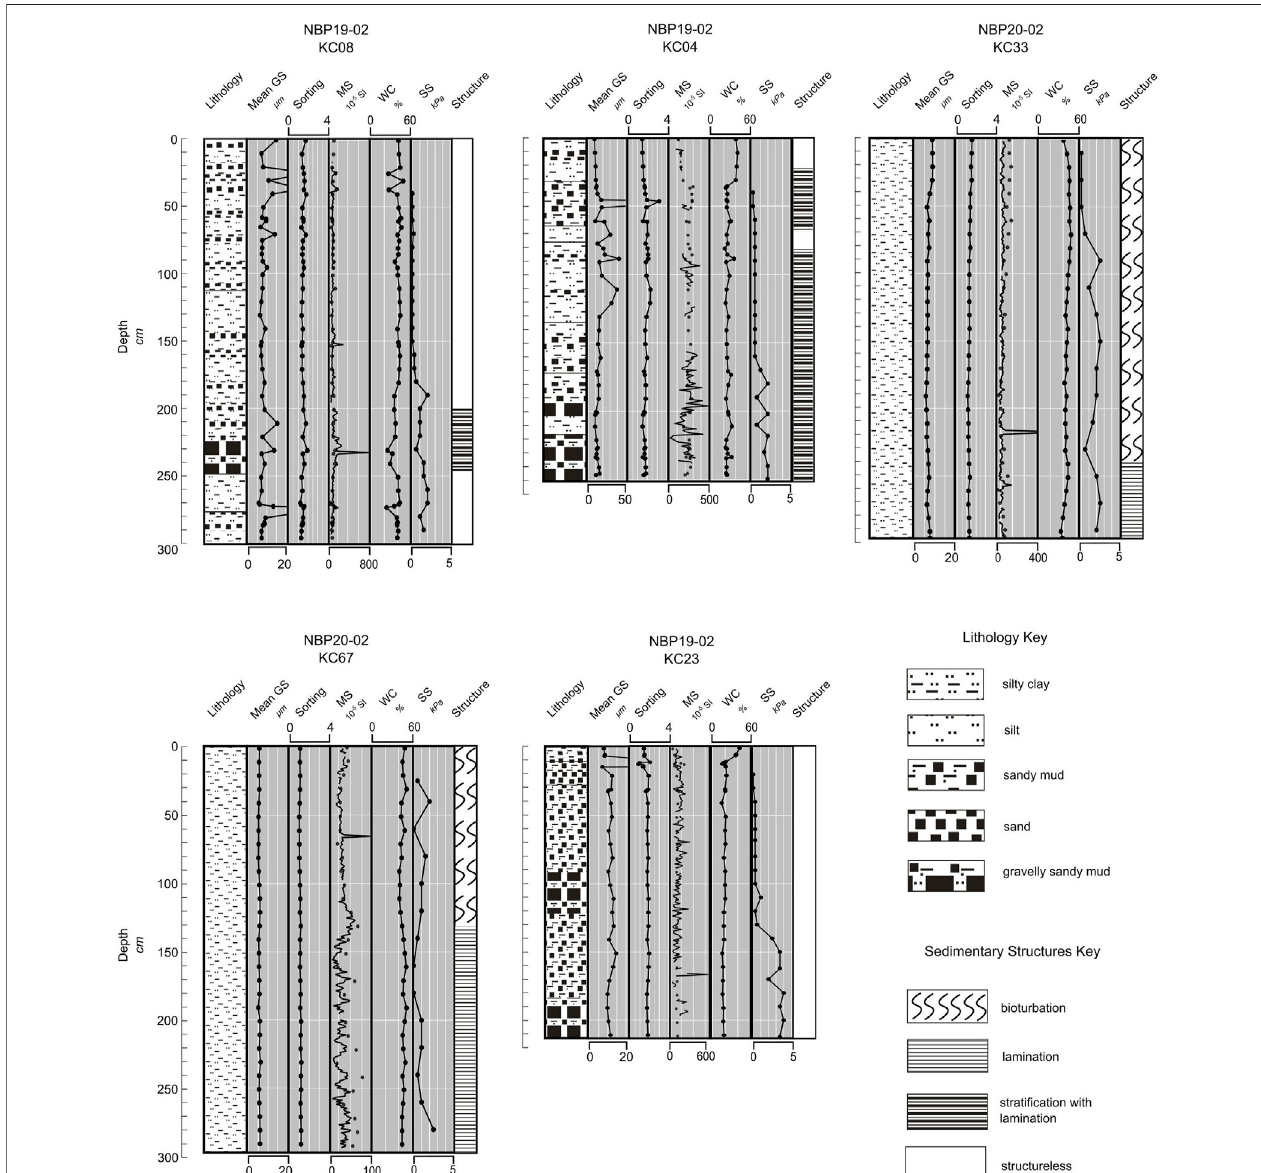
FIGURE 5 | Downcore lithology, physical sediment properties, and sedimentary structures for each core. GS = grain size; MS = magnetic susceptibility; WC = water content; SS = shear strength. Sedimentary structures and stratigraphy are further discussed in Figure 6 with the added context from computed tomography images. Linescan MS pro fi les and discrete MS pro fi les are plotted together as a line and closed circles, respectively. Discontinuous linescan MS pro fi les can result from uneven core surfaces (e.g., KC04). Note the difference in scale of MS and Mean GS between cores.